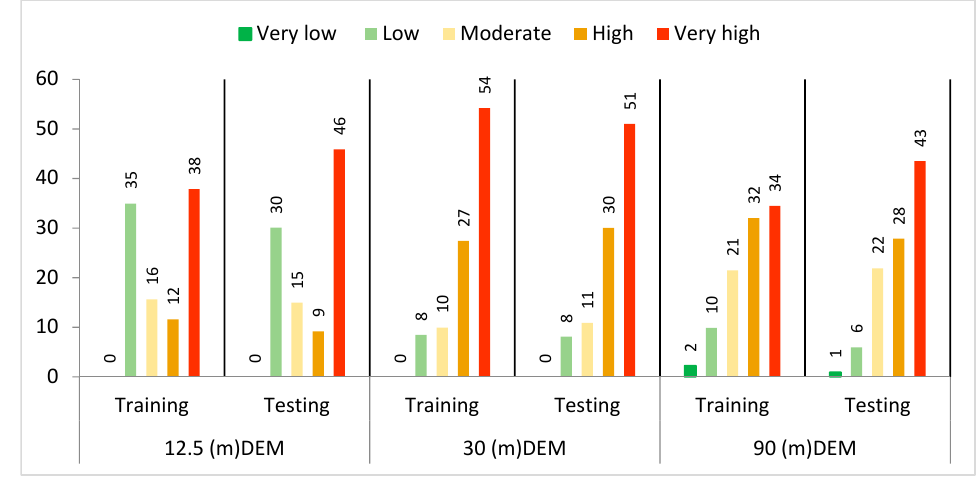
Figure 7. R-index in susceptibility classes for the three different resolution DEMs based on training and testing data.